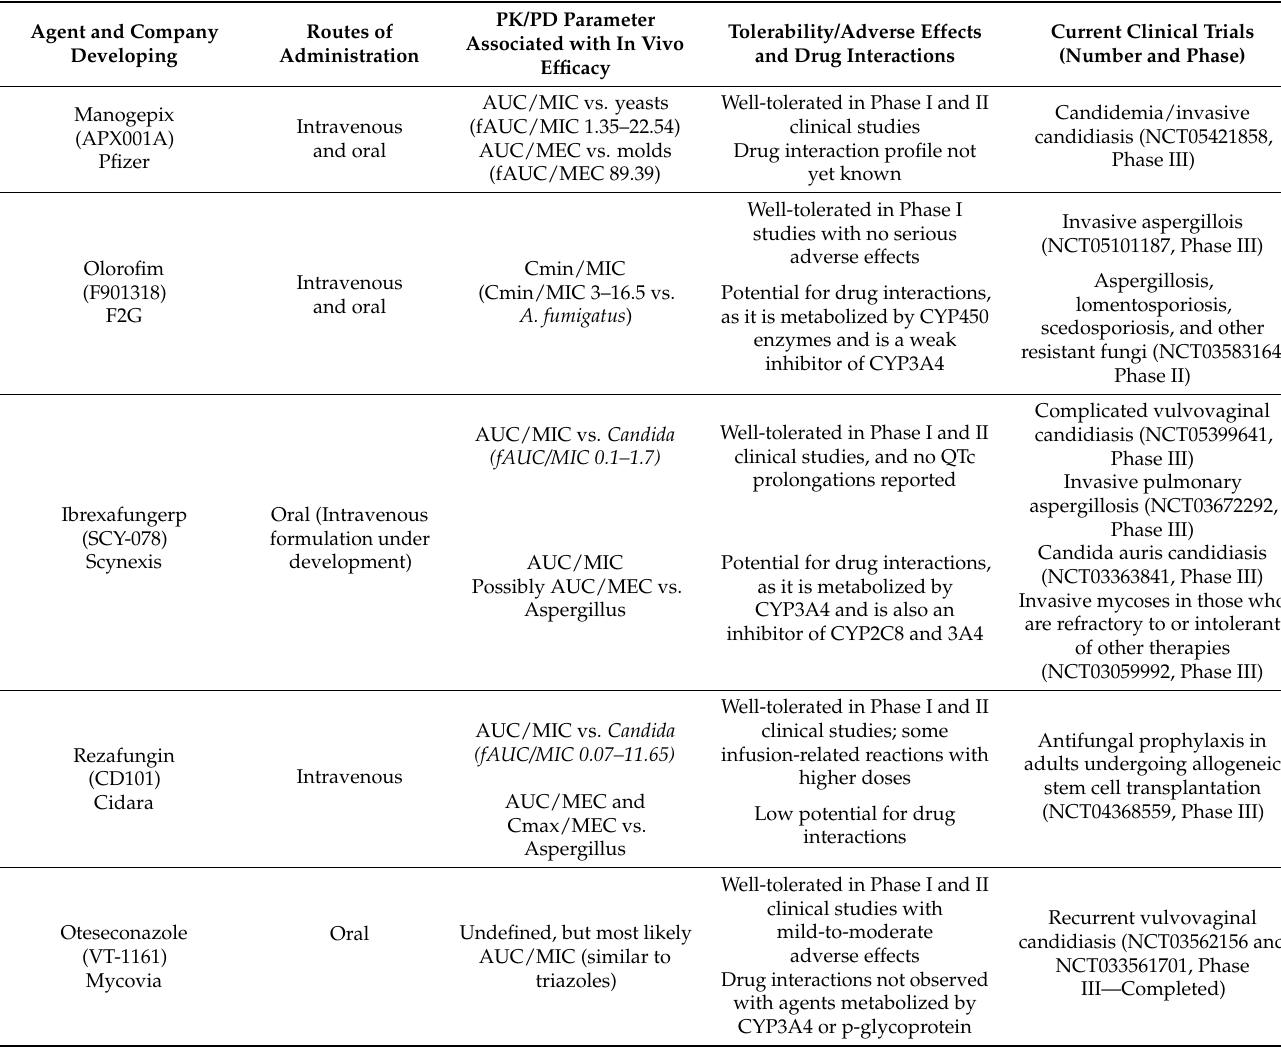
Table 1. Antifungals in late-stage clinical development, routes of administration, pharmacoki- netic/pharmacodynamic (PK/PD) parameters associated with efficacy, tolerability/adverse ef- fects and drug interactions, and current clinical trials. Cmax = peak bloodstream concentration; Cmin = trough bloodstream concentration; AUC = area under concentration curve; fAUC = free drug area under concentration curve; MIC = minimum inhibitory concentration; MEC = minimum effective concentration; CYP450 = cytochrome P450 enzyme; CYP3A4 = cytochrome P450 3A4